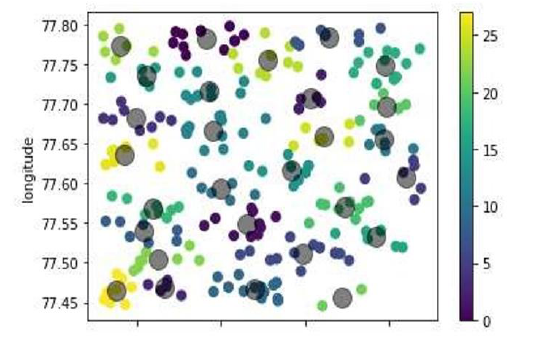
Figure 9. Cluster number=28